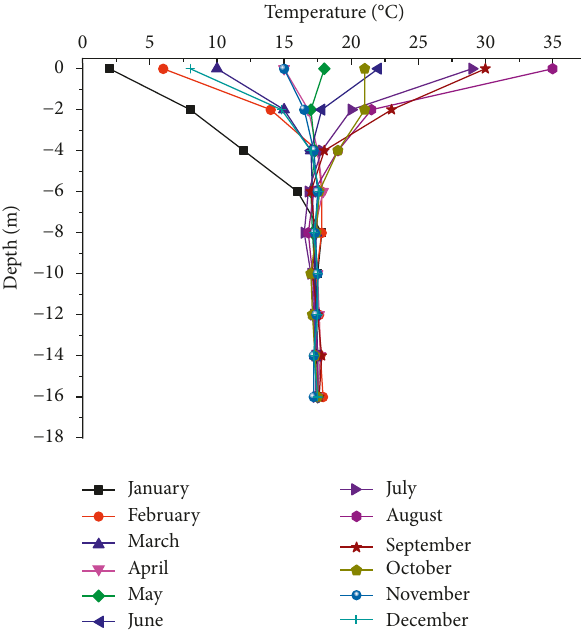
Figure 1: Change in soil temperature with the